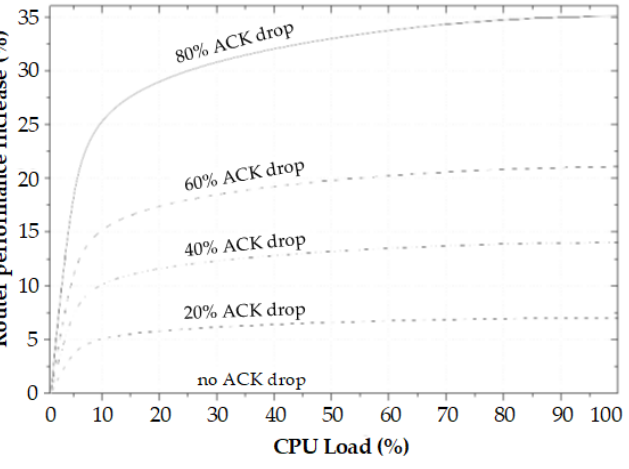
Figure 20. Relation between performance and CPU load in receiving system with ACK